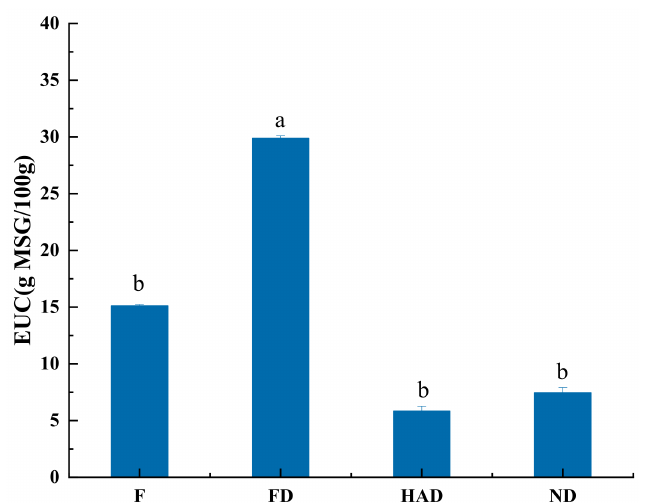
Figure 4. Equivalent umami concentration (EUC) values of fresh and different dried L. edodes ; F: fresh sample; FD: freeze drying sample; HAD: hot-air drying sample; ND: natural drying sample. Means with different letters (a, b) are significantly different ( p <